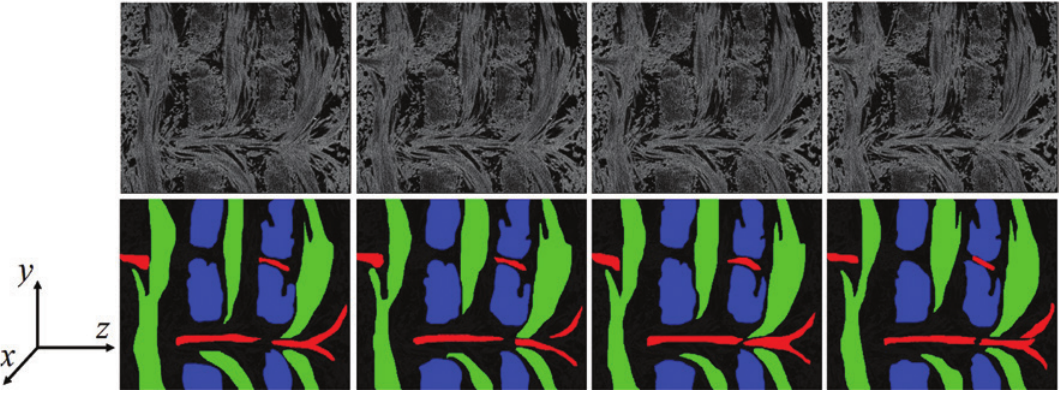
Figure 1: 2D slice sequence for the needle C/SiC composite and the corresponding image series with color marks.